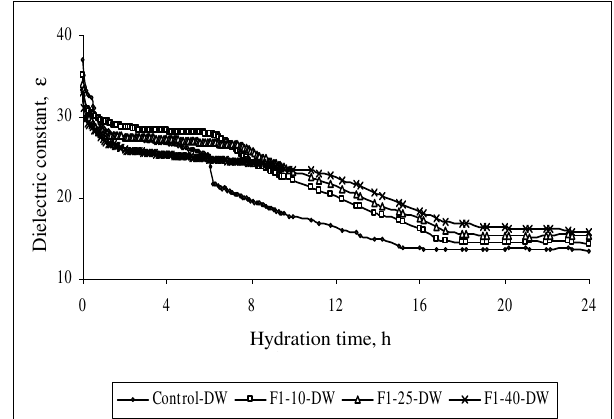
Figure 2. Dielectric constant vs hydration time plot for control and F1 fly ash blended cement composites hydrated with